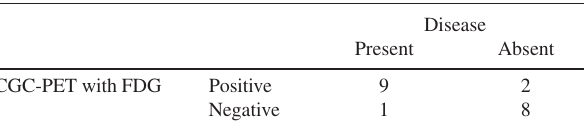
Disease Present Absent